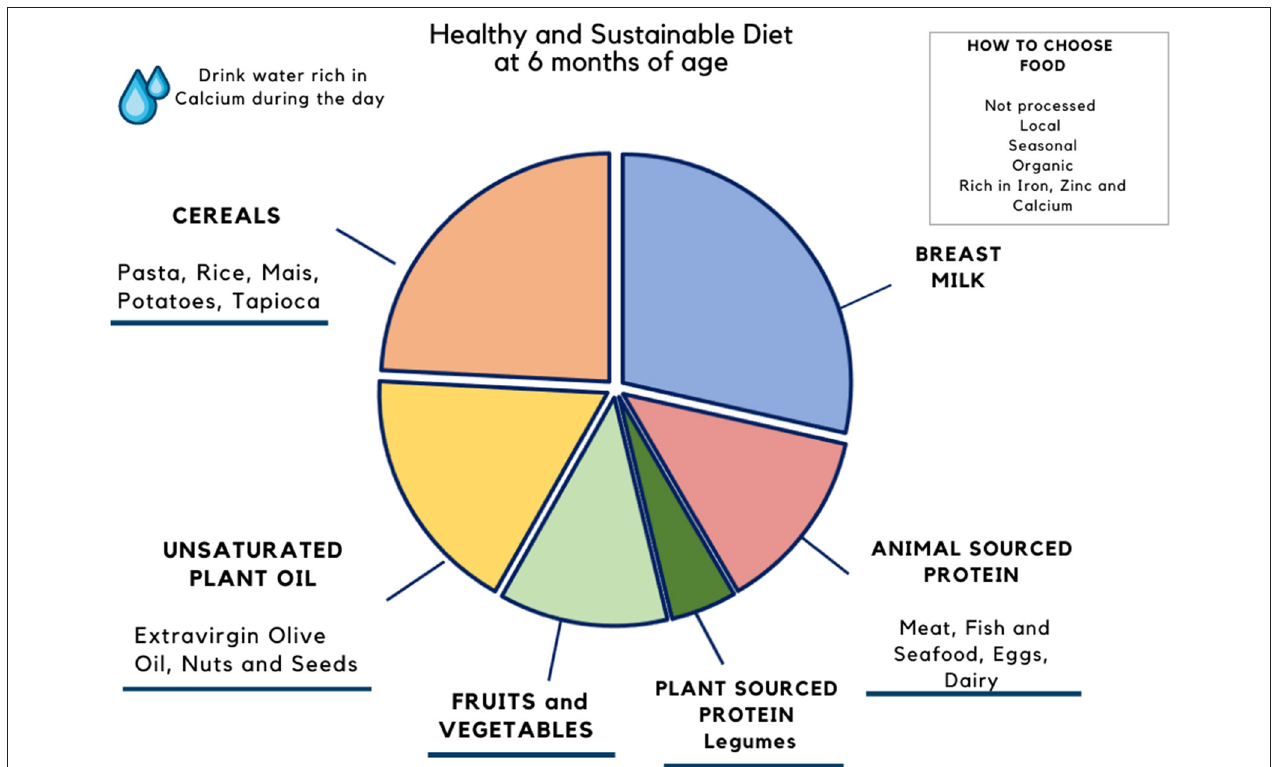
FIGURE 2 | Healthy and sustainable diet at 24 months of age. Proposal of diet at 24 months of age. Percentages refer to the total amount of calories required per day by each food group for a 24-months old baby. From Mazzocchi et al. (